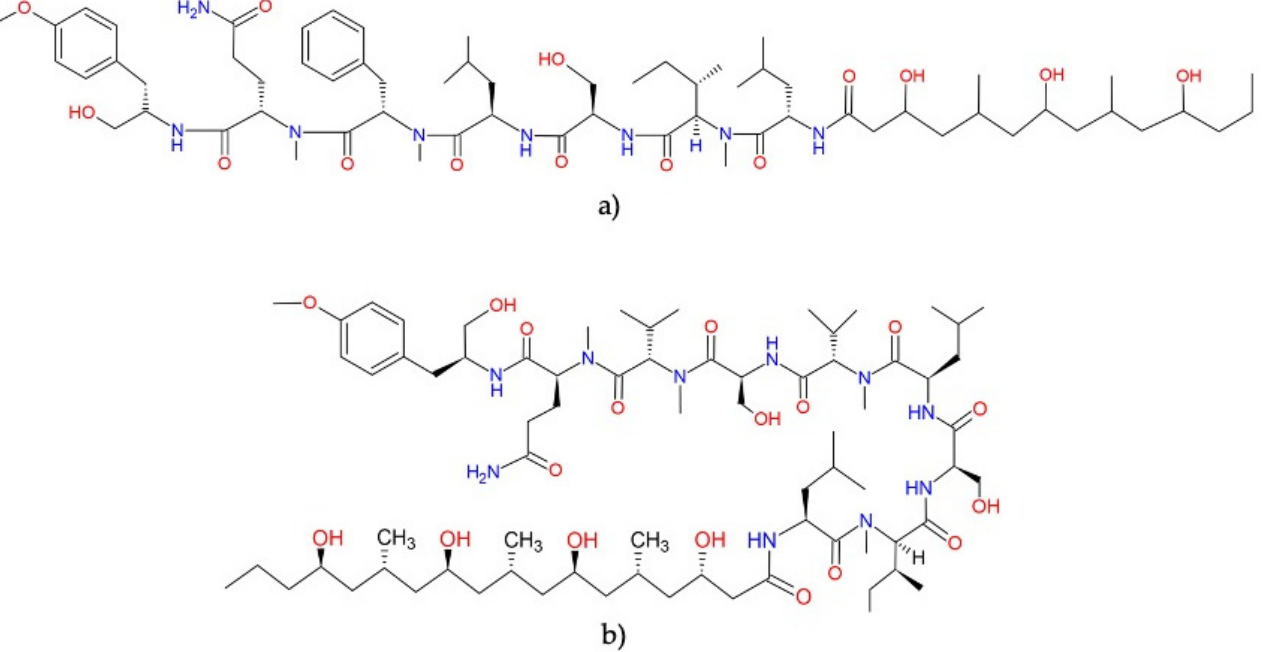
Figure 15. Chemical structures of ( a ) wenchangamide A and ( b ) minnamide A.